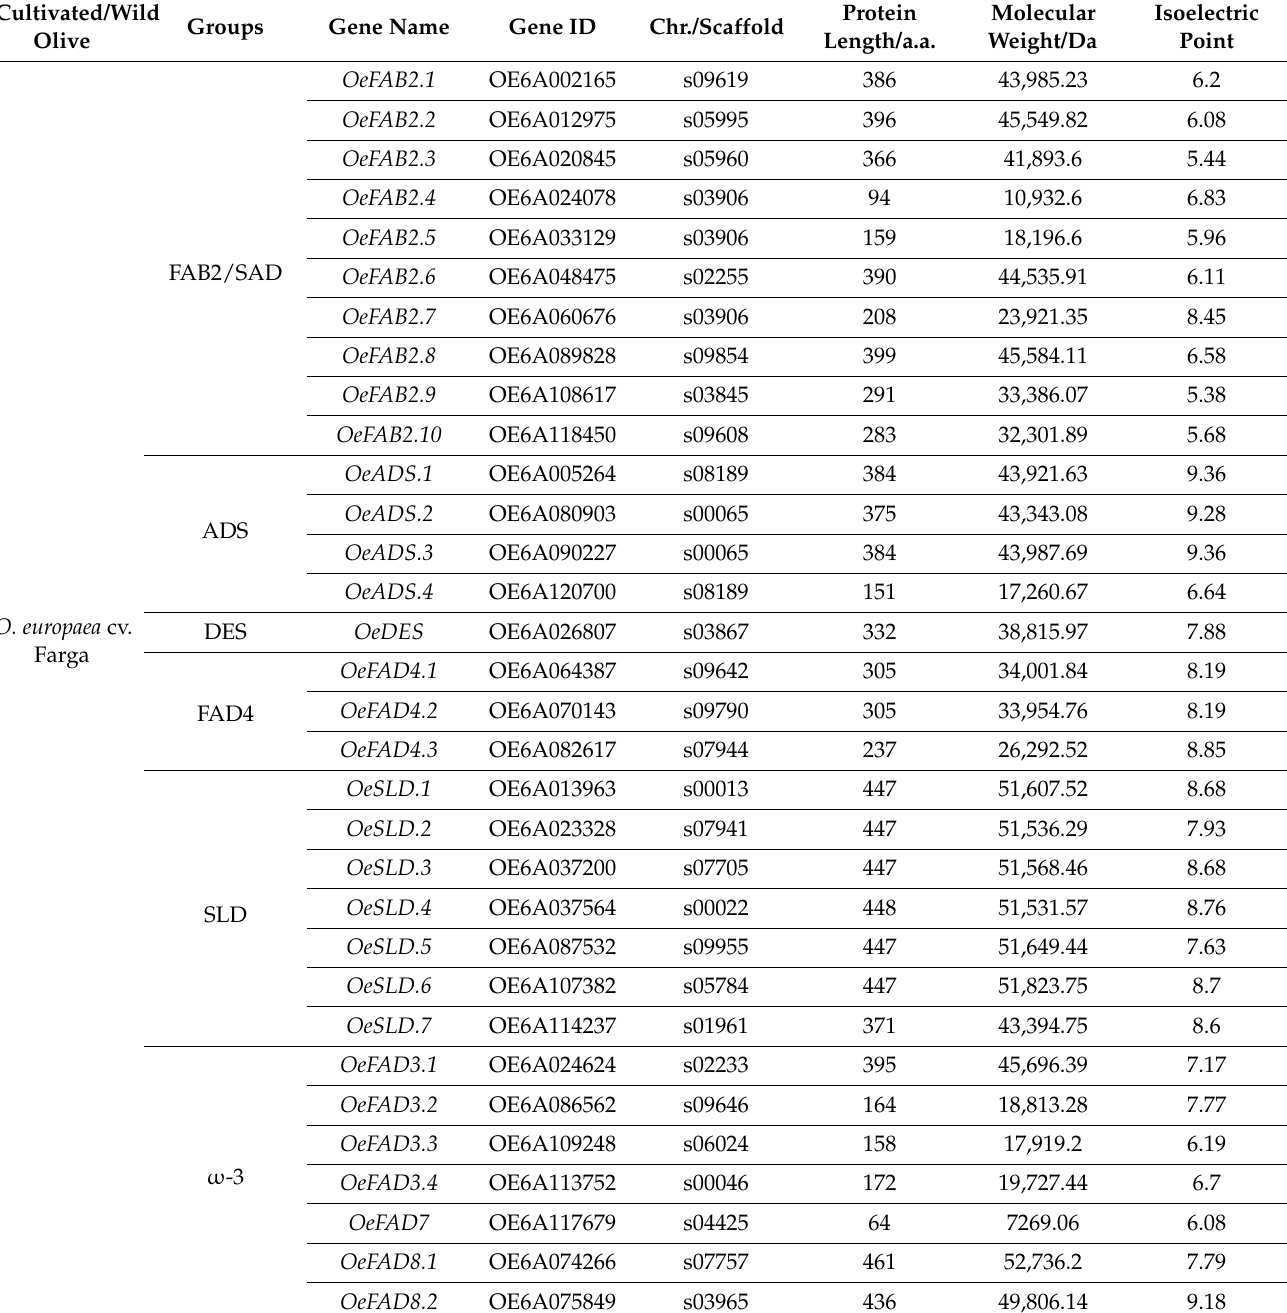
Table 1. Gene IDs and characters of FAD genes in